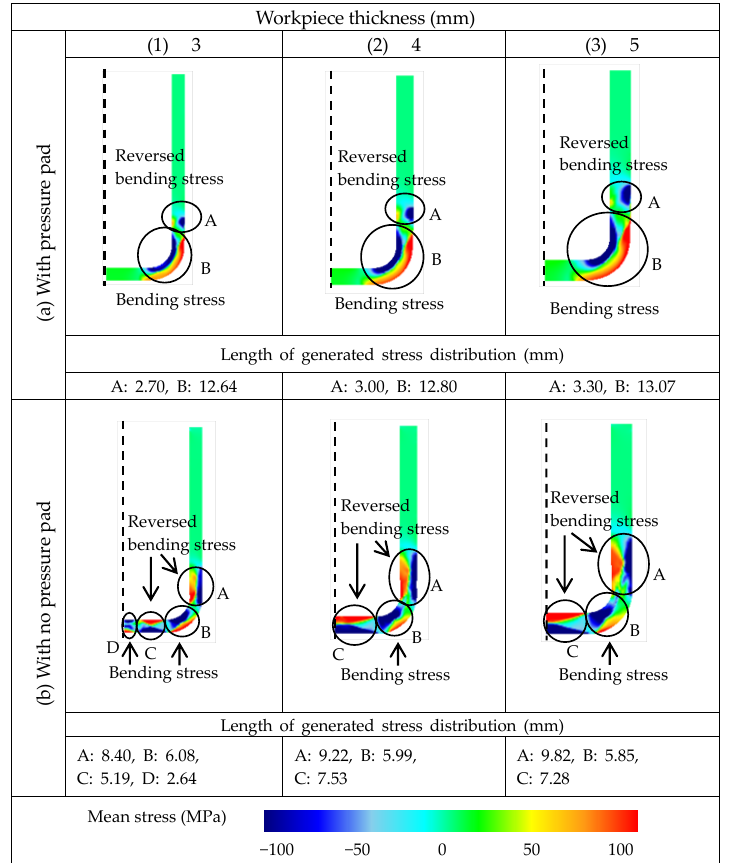
Figure 6. Comparison of the stress distribution analyzed in the workpiece, before unloading, with respect to various workpiece thicknesses (θ: 90°, R p : 5 mm, W : 30 mm, WP L : 120 mm, R ud : 5 mm).